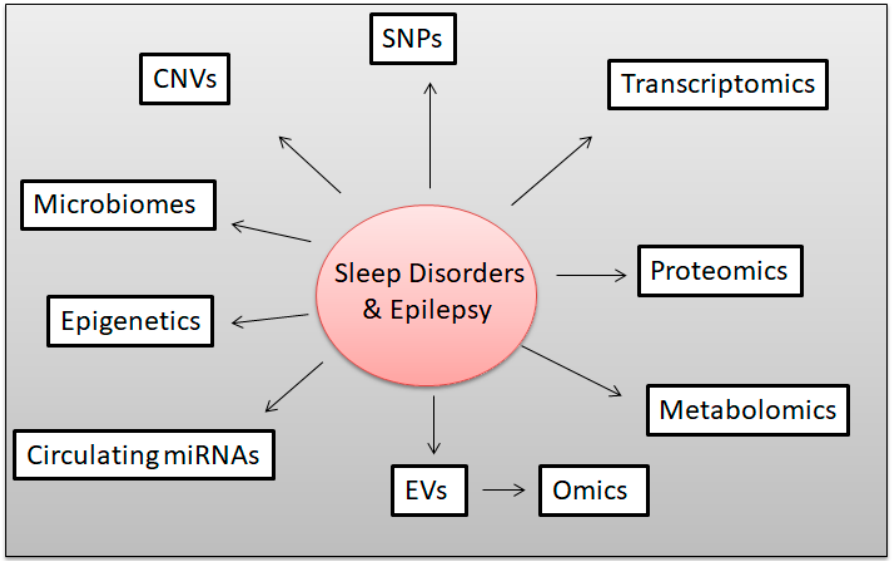
Figure 7. Diagram showing there is an urgent need for multiple disciplines to research children with sleep disorders and epilepsy to better understand the pathophysiology of the disease. This